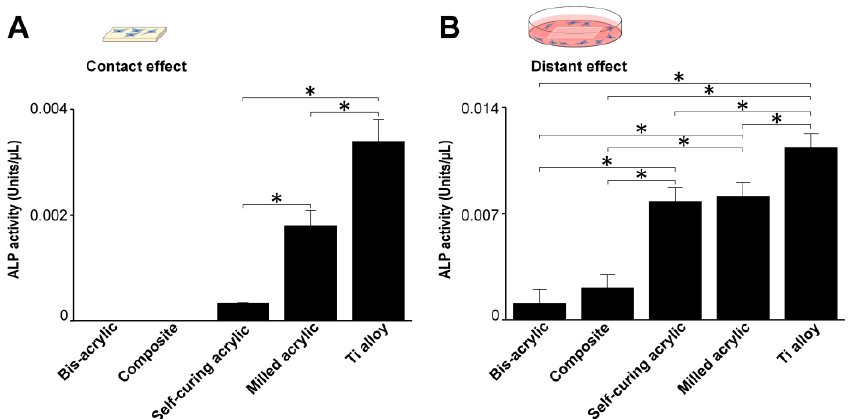
Figure 7. Alkaline phosphatase (ALP) activity of osteoblasts 4 days after seeding. ( A ) ALP activity on test materials and ( B ) around test materials. Data shown are means ± SD (n = 3).Significant dif- ferences are shown (one-way ANOVA with Bonferroni Post hoc test, * p < 0.05).